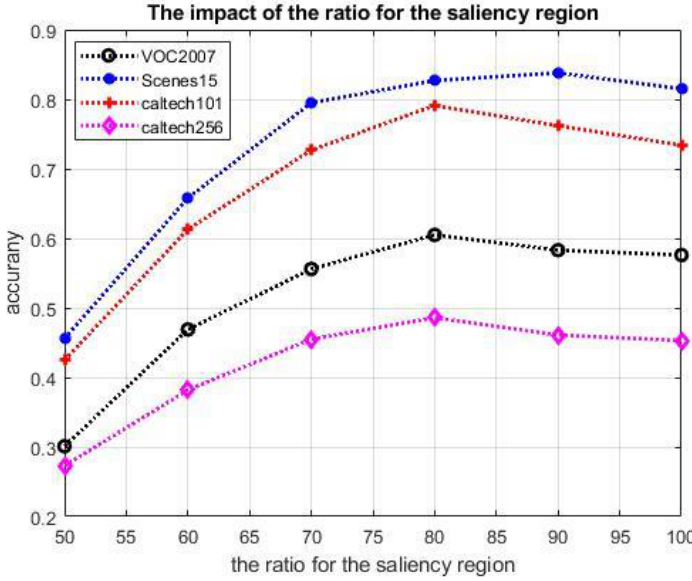
Figure 7. Performance of the improved LLC representation with different saliency region ratios. This